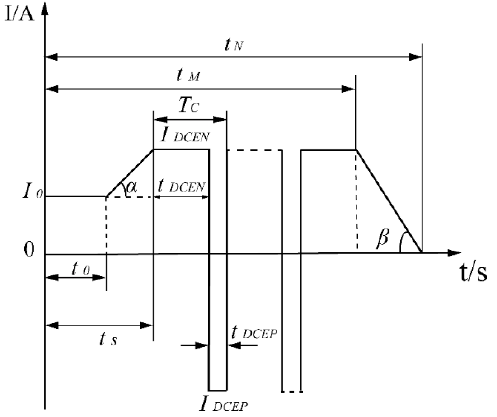
Figure 2. Schematic diagram of current variation during the VPPAW process .